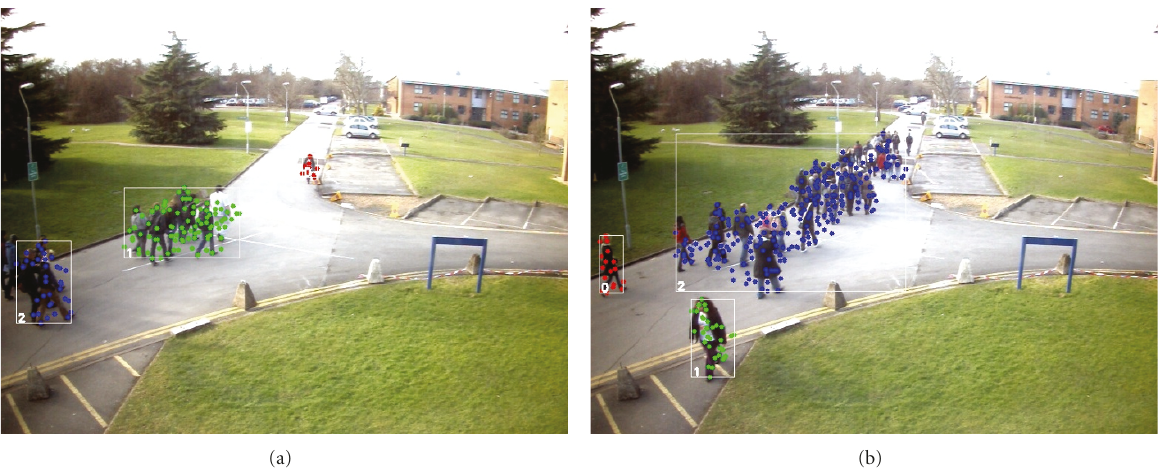
Figure 4: E ff ect of perspective distortion on the number of detected interest points: note how the same woman in (a) is far from the camera (cluster 0, red dots) and only 9 interest points are detected, while in (b) she is closer to the camera (cluster 1, green dots) and 30 interest points are associated to